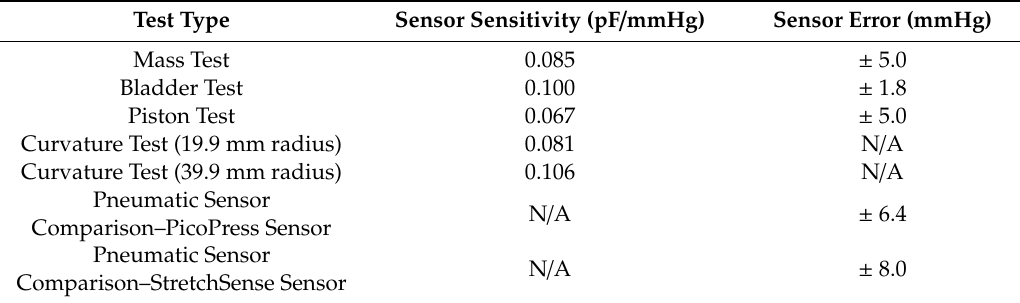
Table 2. Sensor sensitivity and error values for each